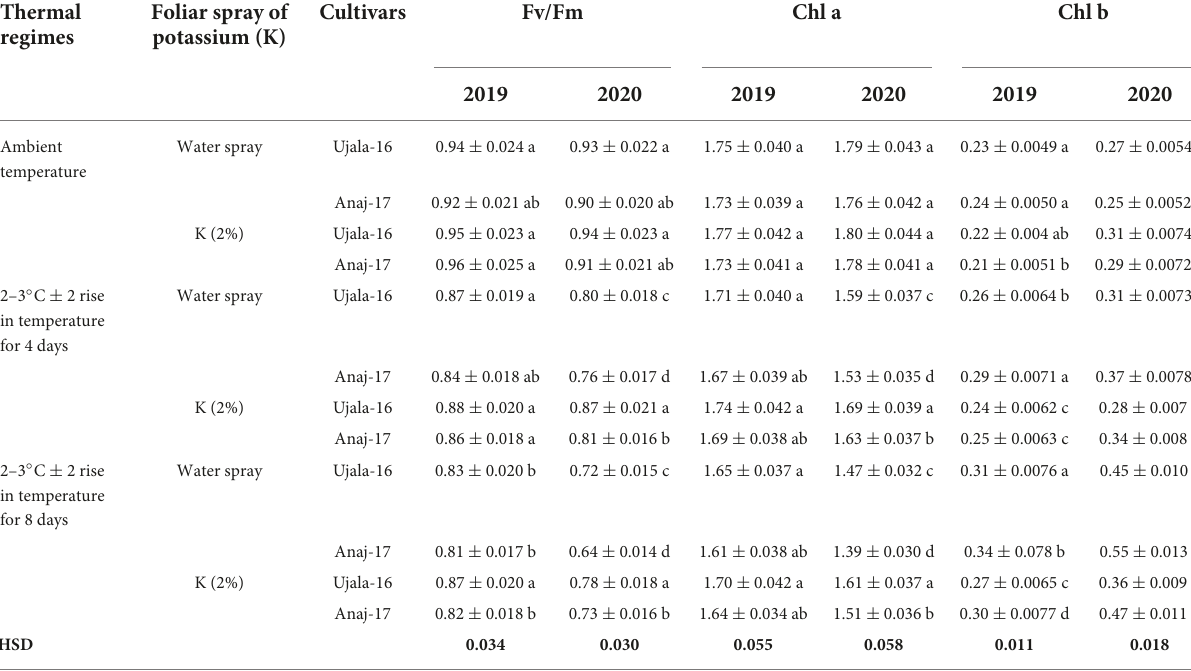
TABLE 3 Effect of optimal and stressful conditions of pots, potassium spray and cultivars on chlorophyll fluorescence (Fv/Fm) and chlorophyll contents (Chl a, b mg g − 1 FW) of wheat flag leaves under 4 and 8 days of heat stress 1 week after anthesis. Thermal